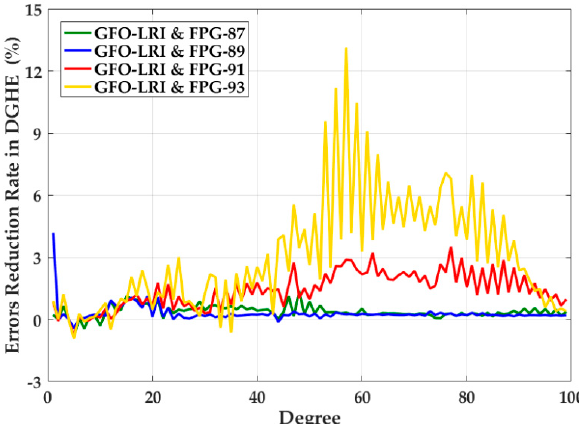
Figure 4. Error reduction rate (ERR) of different GFO-LRI & FPG combined models with respect to the GFO-LRI standalone model in terms of degree geoid height error (DGHE) in January 2006.